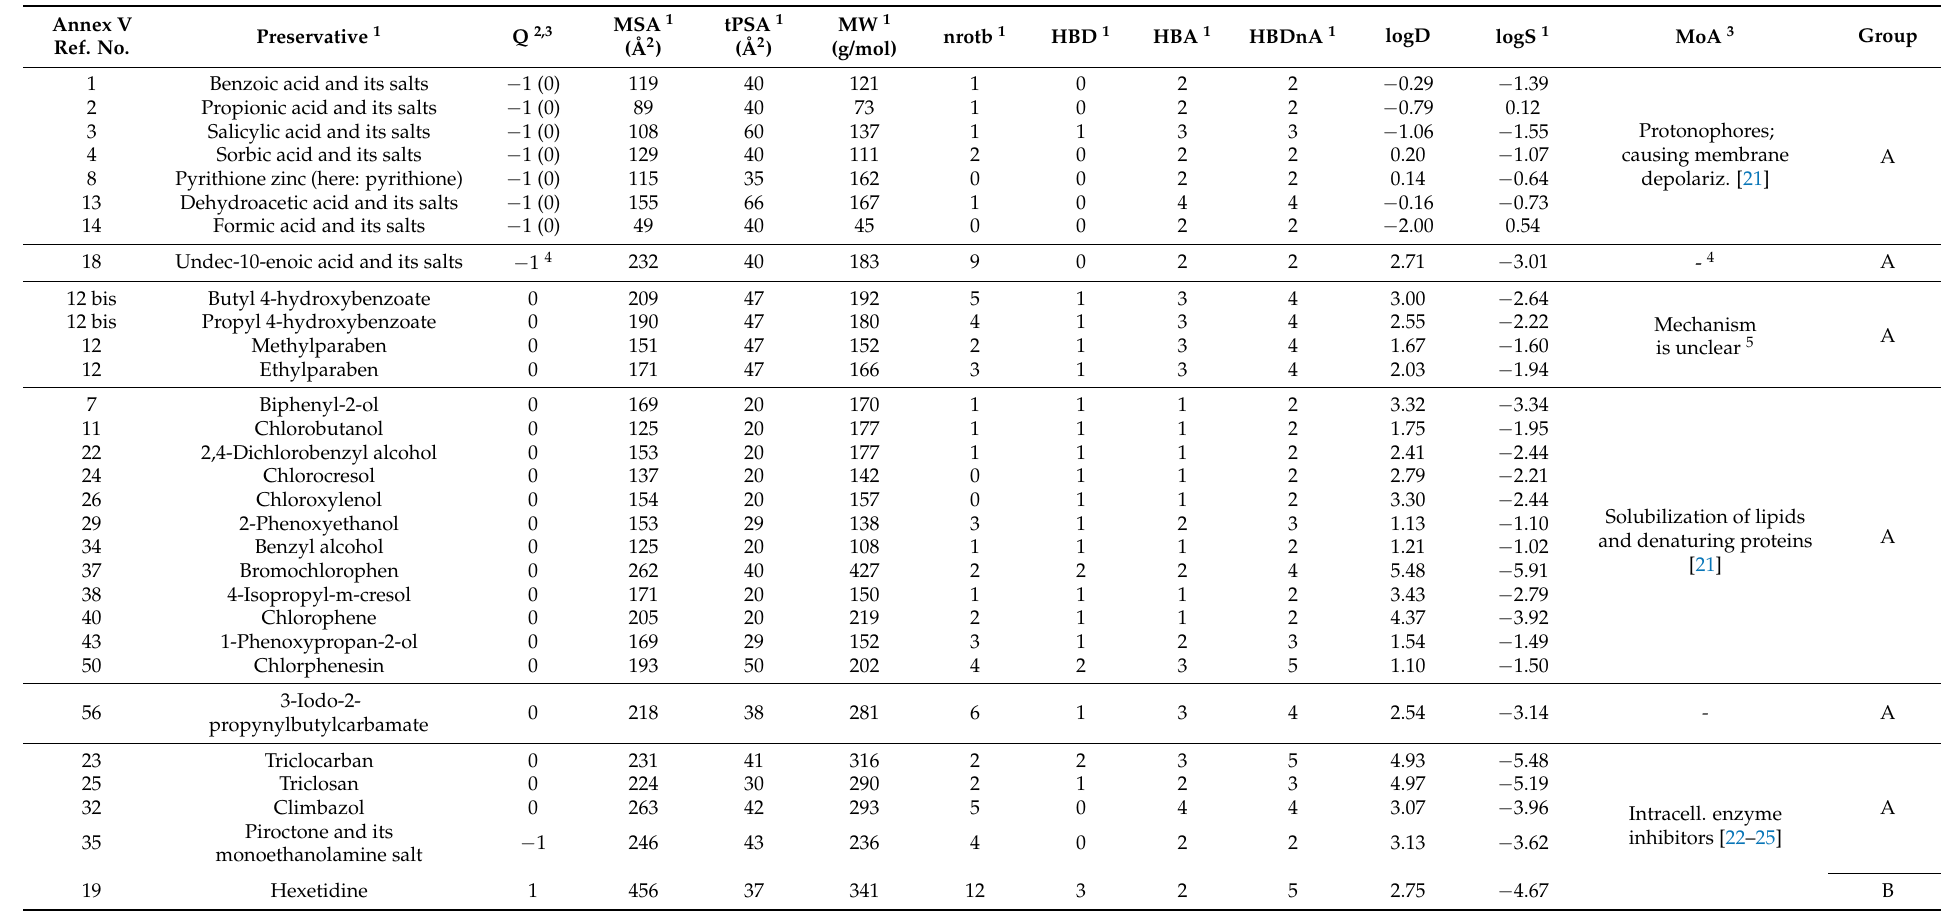
Table 1. Calculated molecular descriptors of preservatives, which were used for empirical analysis of privileged chemical